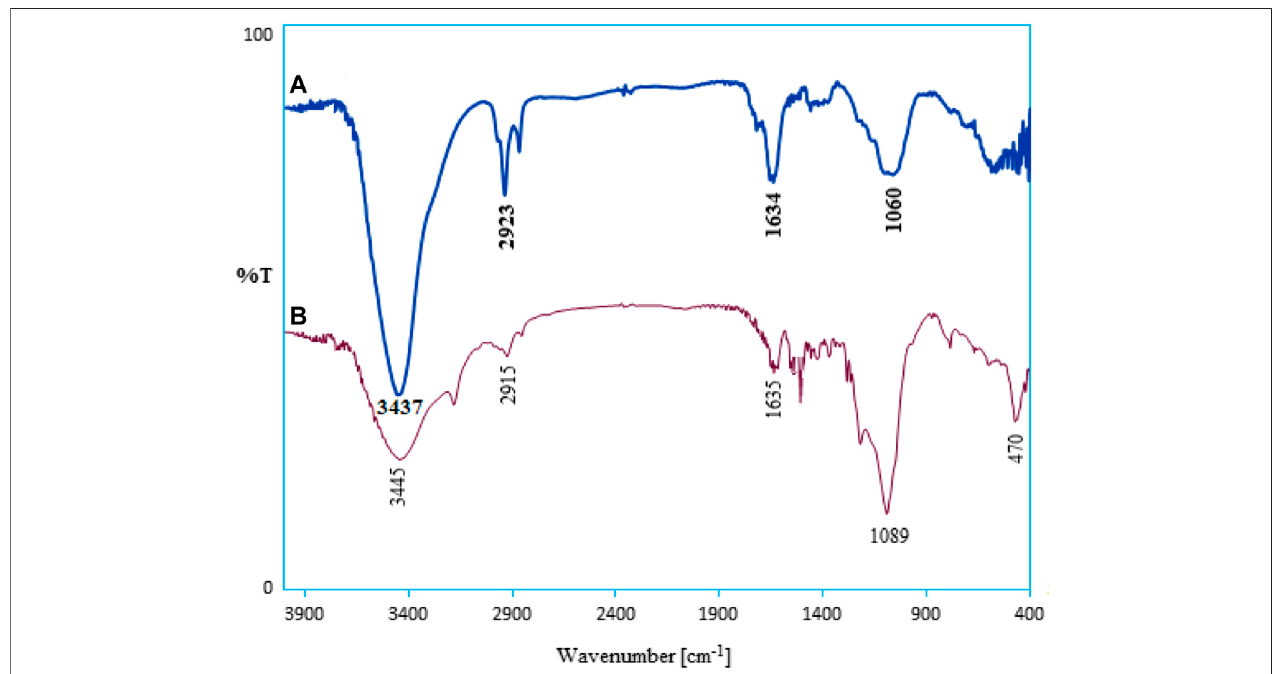
FIGURE 8 | FT-IR spectra of the (A) fresh catalyst and (B) recovered Pd/TCH@SBA-15 catalyst after 5 cycles.